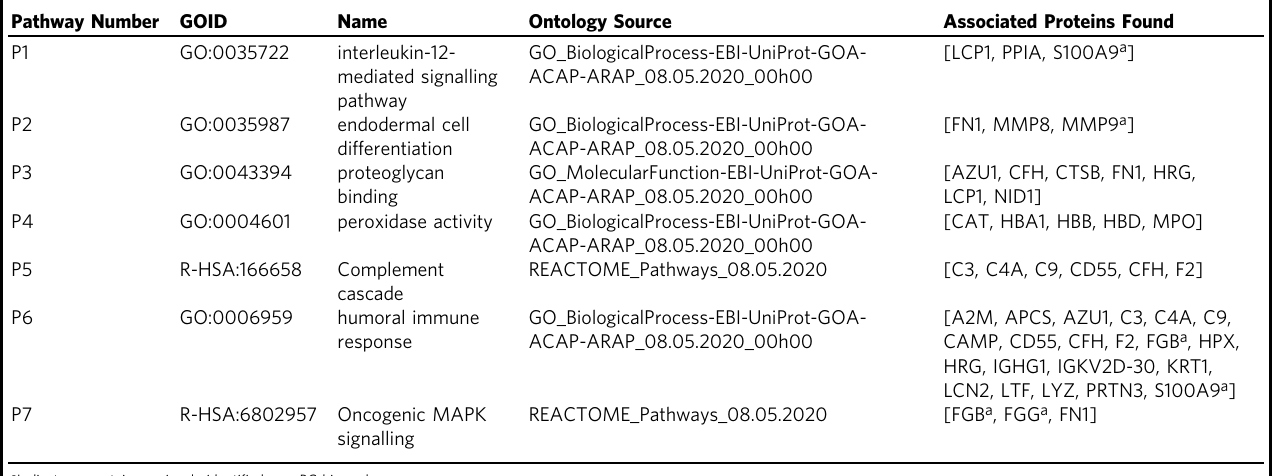
Table 1 Pathways and proteins used on the longitudinal follow up of bladder cancer patients. Pathway Number